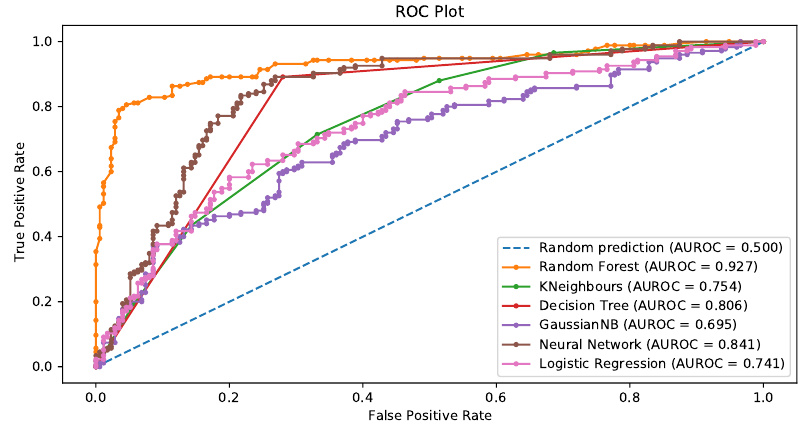
Figure 14. Random oversampling.